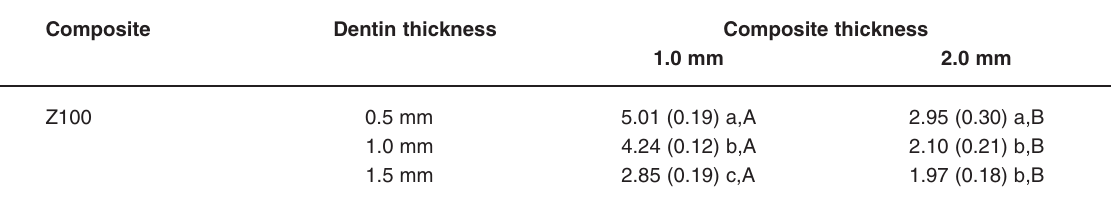
Different lowercase letters in columns and uppercase letters in rows indicate statistically significant difference (Tukey’s test, p<0.05). Standard deviations are given in